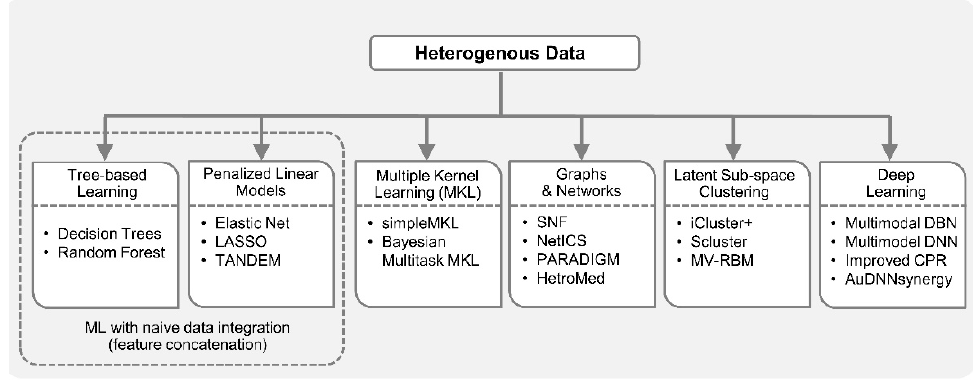
Figure 2. Machine learning with heterogenous data. ML algorithms can handle heterogenous data in different ways. For naive feature concatenation-based data integration, tree-based methods (e.g., decision trees and random forest), and penalized linear models (e.g., elastic net and LASSO) can be employed. A two-stage elastic net-based approach like TANDEM is useful if data sources with continuous features (e.g., gene expression) dominate the data sources with binary features (e.g., mutation). Multiple kernel learning (MKL), a robust integrative analysis approach with heterogenous data, employs different kernels or similarity functions for data from different sources and fuses them into a global matrix. Bayesian multitask MKL and simpleMKL are notable examples in this category. Network fusion methods such as similarity network fusion (SNF) employ similarity network for each data type and fuse heterogenous networks. PAthway Recognition Algorithm using Data Integration on Genomic Models (PARADIGM) can incorporate different heterogenous data including gene expression, copy number and curated pathways. Network-based Integration of Multi-omics Data (NetICS) integrates multi-omics data on a directed functional interaction network. Heterogenous information networks like HetroMed can handle raw text, numeric, and categorical data in electronic health records (EHRs) for medical diagnosis. Integrative methods including iCluster+, Scluster and mixed variable restricted Boltzmann machine (MV-RBM) first transform data from heterogenous sources into latent sub-space, and then perform clustering on the latent profiles. Deep learning models such as improved Clustering and PageRank (CPR), Deep Neural Network Synergy model with Autoencoders (AuDNNsynergy), multimodal deep belief networks (DBN) and deep neural networks (DNN) have been employed to perform integrative analysis of heterogenous data by learning complex features through data transformations at multiple layers.